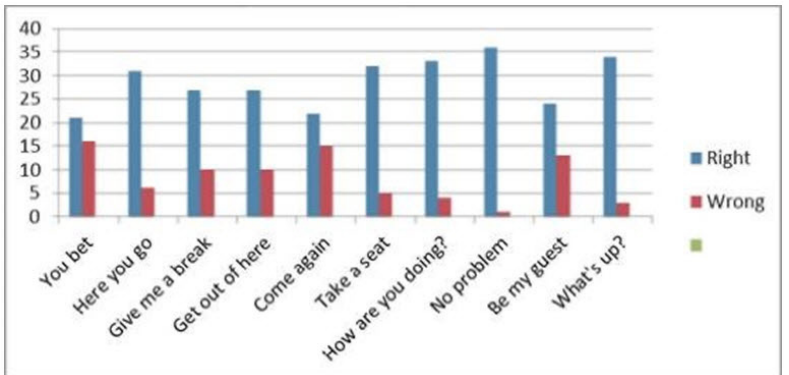
Figure 4. Correlation of correct and incorrect interpretations of situationally conditioned expressions with the context available (for